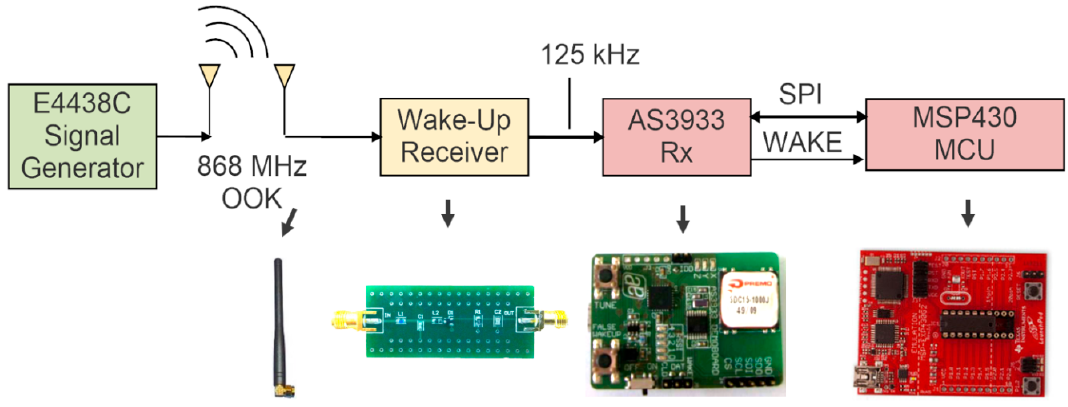
Figure 7. Scheme for the WuR prototype for validation.